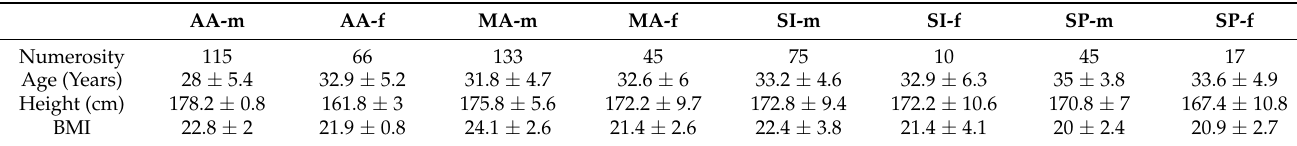
Table 1. Anthropometric characteristics of the enrolled subjects.